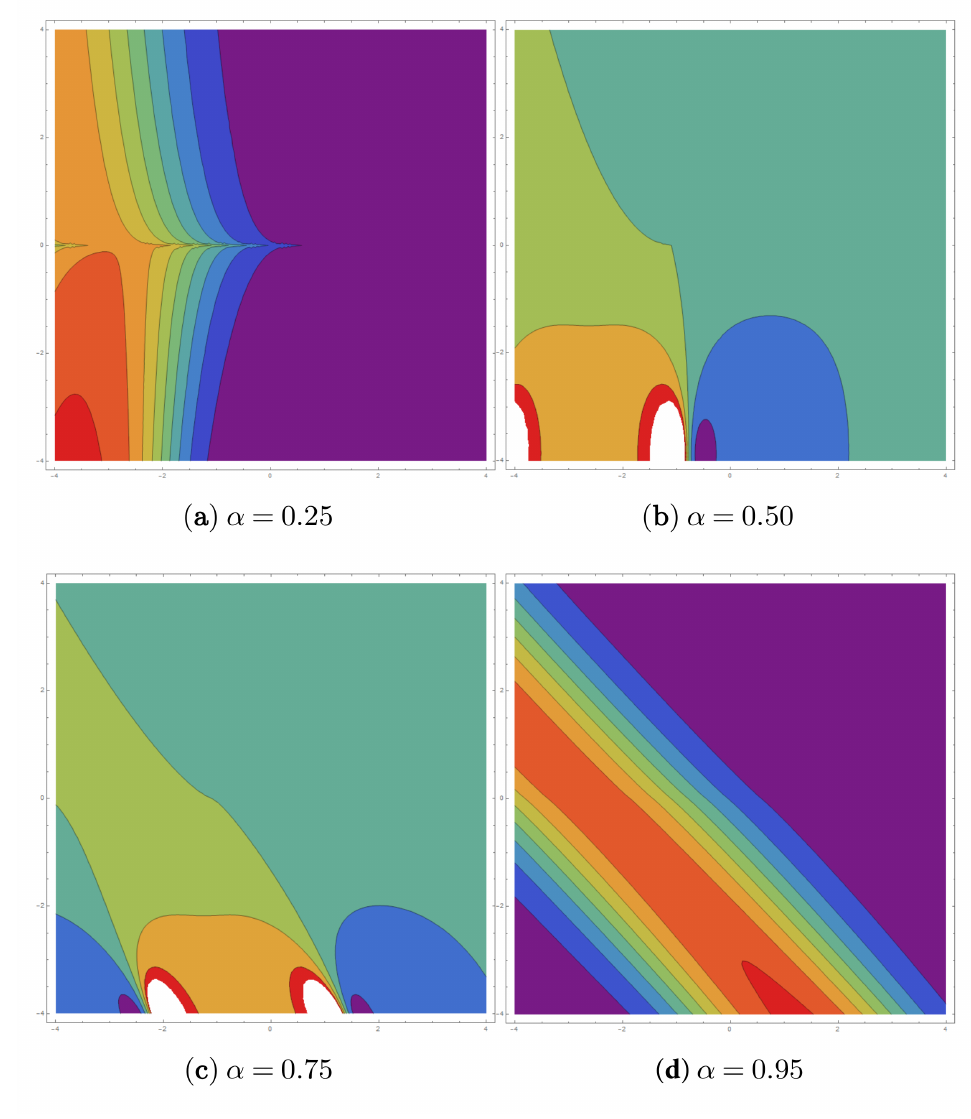
Figure 10. The 2D contour graphs for S 5